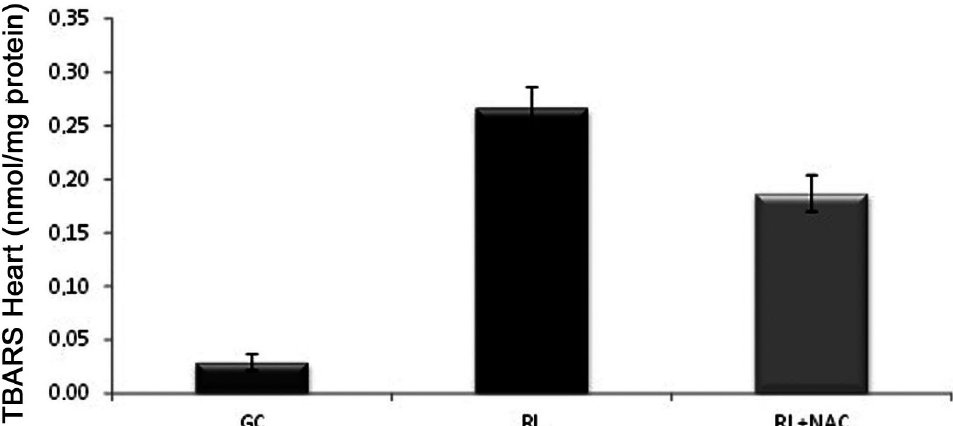
Fig. 1 - Thiobarbituric acid reactive substances (TBARS) values in cardiac tissue in the control group (GC), Ringer Lactate (RL) and Ringer lactate with N-acetylcysteine group (RLNAC). GC < RL, RLNAC; RLNAC < RL, P<